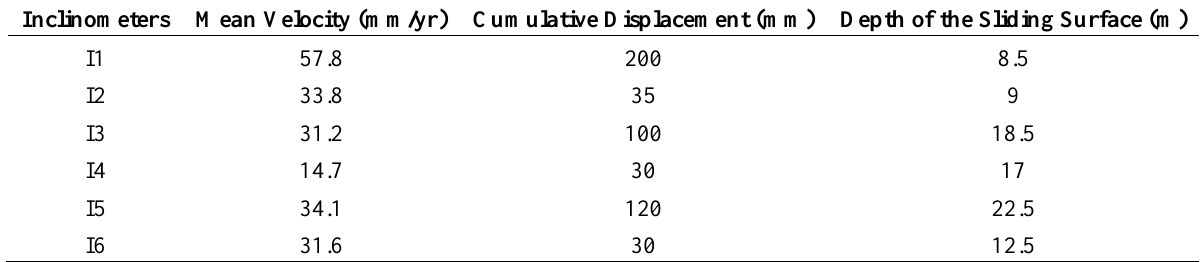
Table 1. Mean velocity and depth of the sliding surface for each inclinometer.